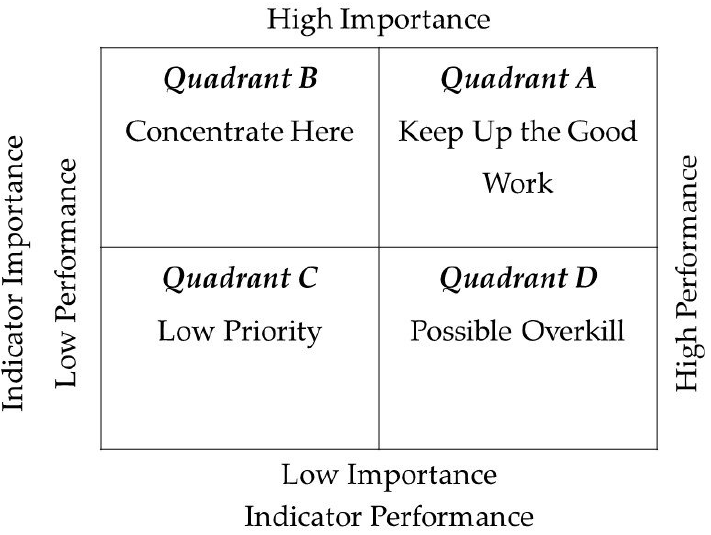
Figure 2. Evaluation framework for importance and performance analysis (revised from [42]).